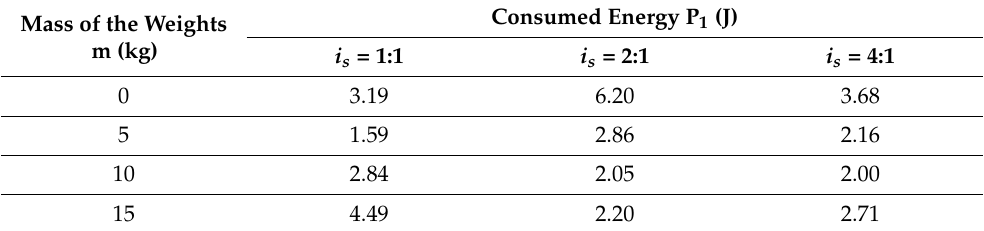
Table 3. Values of energy E 1 consumed during reconstruction of a triangular motion profile. Mass of the